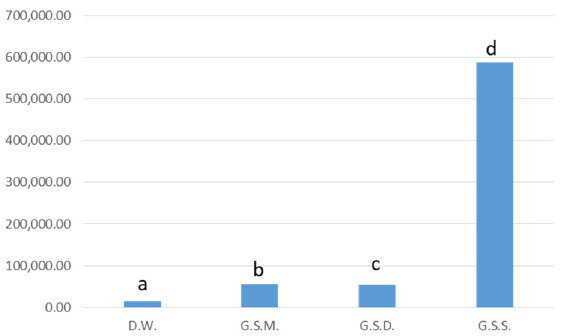
Figure 3. Resveratrol content in D.W. (dealcoholized wine), G.S.M. (grape skin microwave), G.S.D. (grape skin decoction), G.S.S. (grape skin soxhlet); the values are expressed in µg/g. Based on Tukey2019s assay at p < 0.05, different letters (a, b, c and d) indicated significant differences among the tested extracts (a: the highest value).